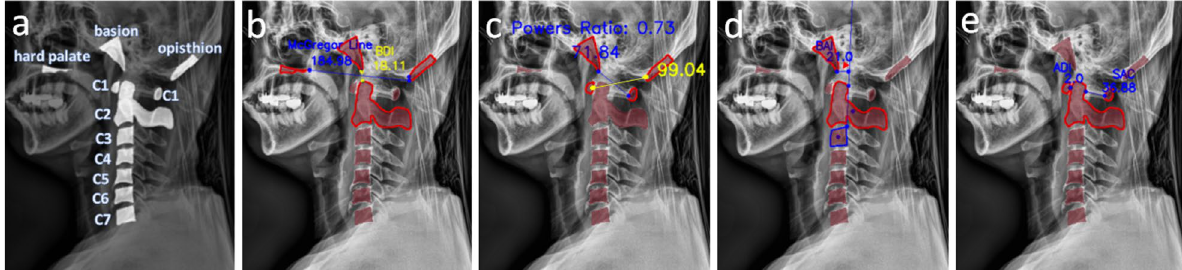
Figure 1. Example of metrics measured for TAOD diagnosis. ( a ) Bone structures of the cervical spine used for measuring TAOD diagnosing metrics. ( b ) McGregor line is a line that connects the posterior edge of the hard palate and the most caudal point of the opisthion. BDI is defined by the distance from the most inferior edge of the basion to the closest point of the superior edge of C2. ( c ) Power’s ratio, calculated by dividing the distance of the most inferior edge of the basion to the center edge of the right C1 by the distance of the leftmost point of the opisthion to the center point of the left C1. ( d ) BAI (line designated by the red arrow) is measured by the closest distance between the most inferior edge of the basion to the line that extends cranially along the posterior cortex of C2. ( e ) ADI refers to the closest distance between the center point of left C1 to the superior region of C2, while SAC refers to the closest distance between the center point of right C1 to the superior region of C2. All distances shown in this figure are in